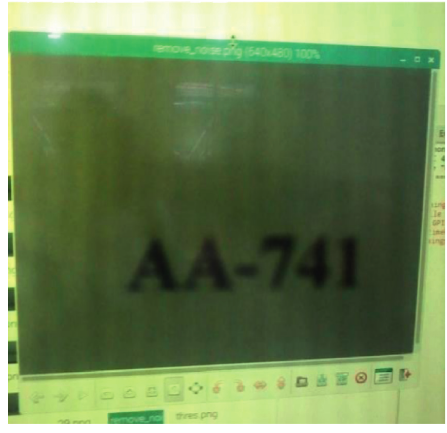
Figure 6: Threshold text image. Figure 7: Noiseless text